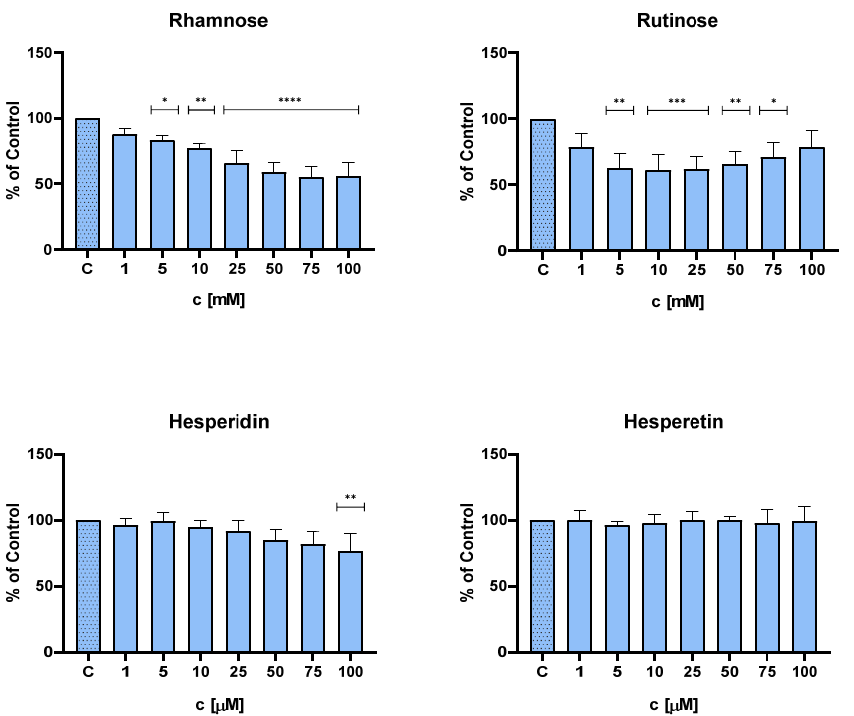
Figure 3. Effect of rhamnose, rutinose, hesperidin, and hesperetin on NHDFs viability. Untreated NHDFs cultured in a serum-free medium containing DMSO (0.1%; v/v ) were used as a negative control (C). Results are expressed as a percentage of control viability and SD. Number of measurements: n = 4. * p < 0.05; ** p < 0.01; *** p < 0.001; **** p < 0.0001 were considered significant compared to control. (One-way ANOVA; Dunnett’s multiple comparisons tests were performed using GraphPad